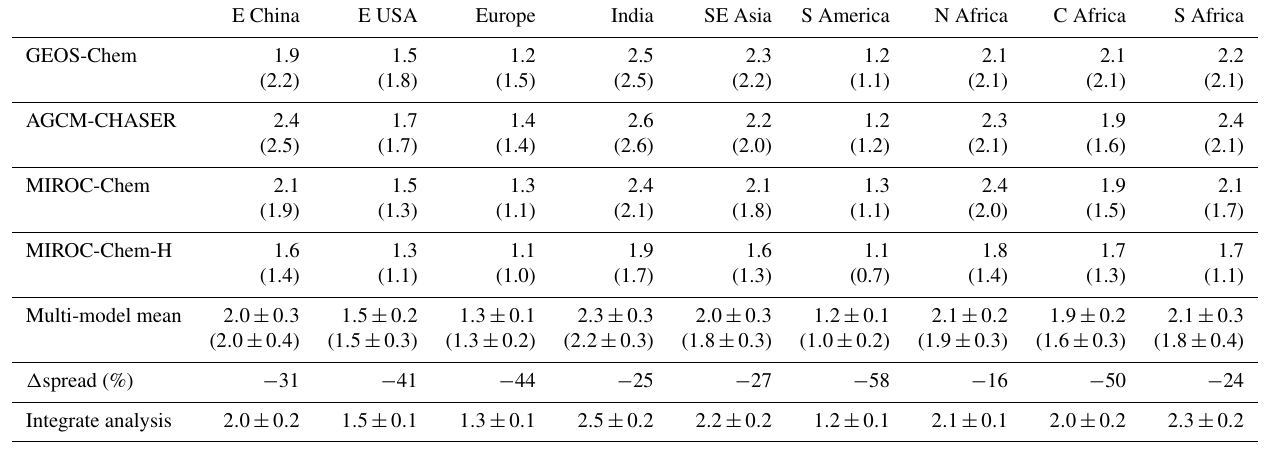
Table 5. Annual and regional mean OH concentration at 700hPa. Units are 10 6 moleculescm − 3 . The results of the control run are also shown in brackets. The results are shown for individual models, the multi-model mean (mean ± 1 σ ), and integrated analysis ( x m ± σ 2 m ). Changes in the multi-model spread due to data assimilation ( (cid:49) spread, %) are also shown.